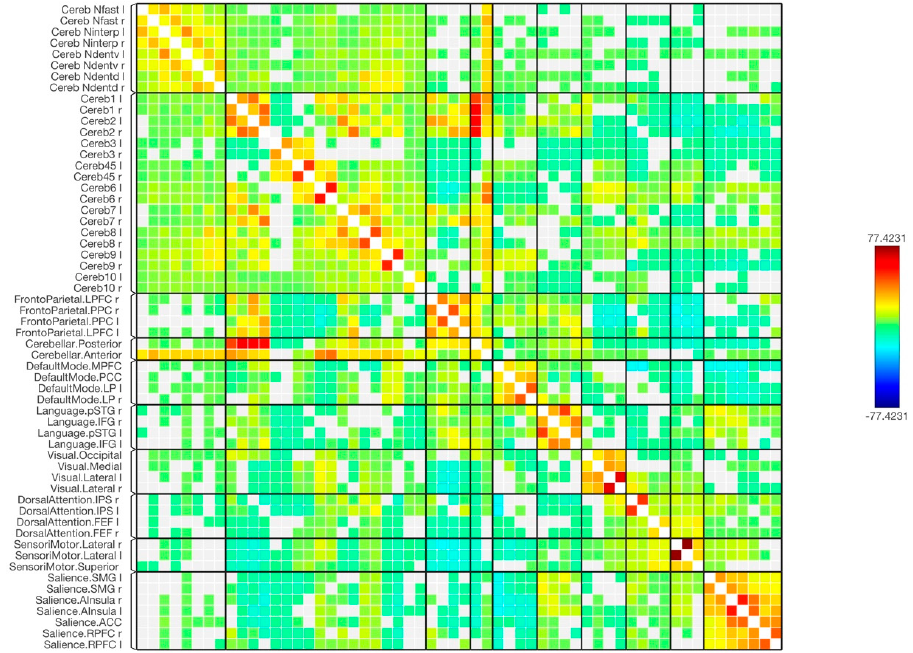
Figure 4. The matrix of the functional connectivity of the cerebellar lobules and their nuclei as well as the targeted brain networks is shown along with the statistical indications of the strength of the connection.